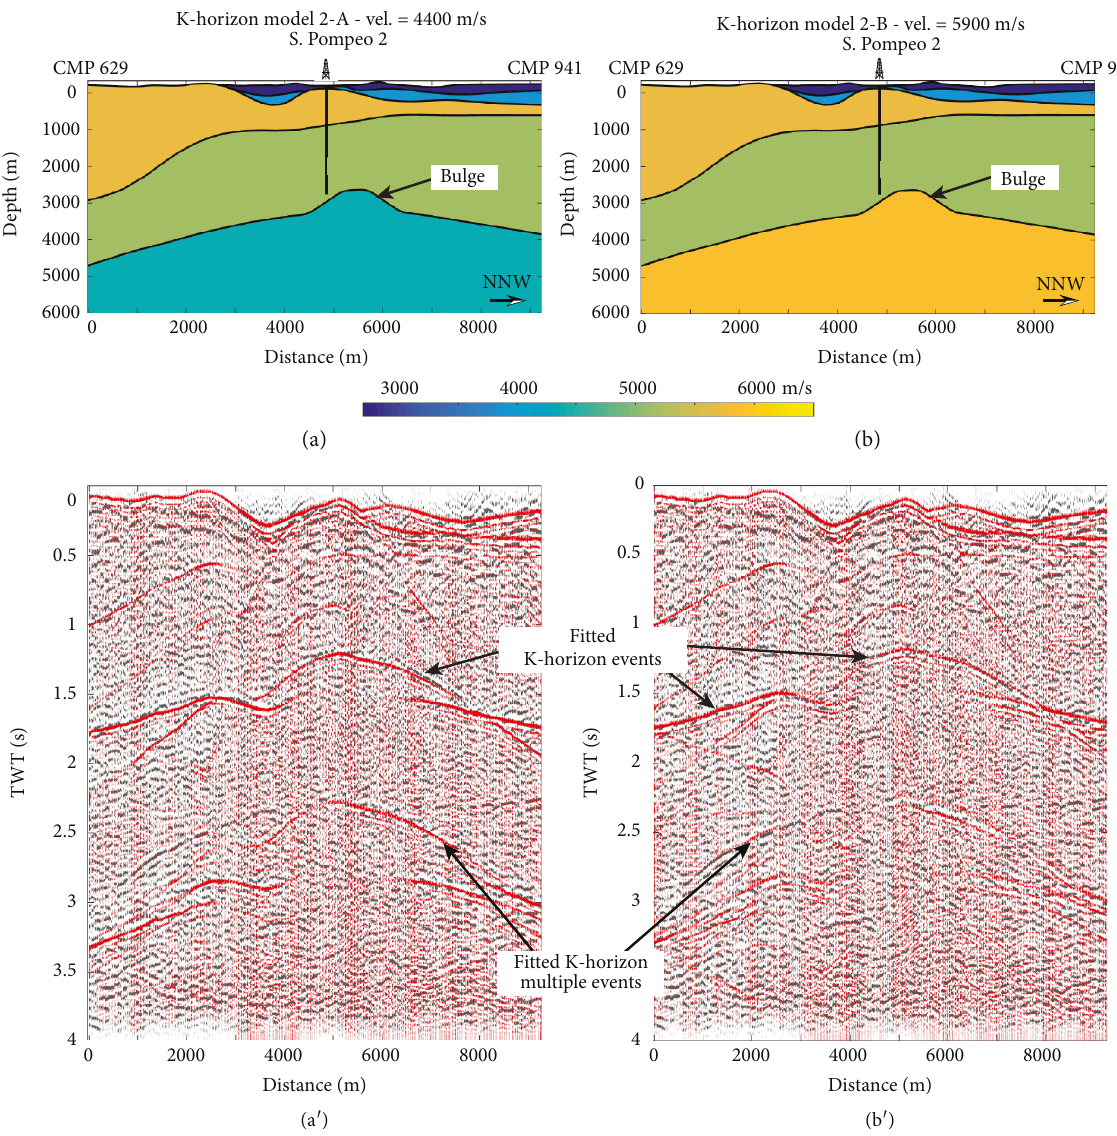
Figure 10: (a) Velocity model, named model 2-A, based on the 3D geological reconstruction obtained after the calibration with CROP-18A data and imposing a velocity value of 4400 m/s for the geological unit below the K-horizon. (b) Velocity model, named model 2-B, based on the 3D geological reconstruction after the calibration with CROP-18A data and imposing a velocity value of 5900m/s for the geological unit below the K-horizon. (a ′ ) Modelled stacked sections for model 2-A (a) with P velocity of the unit below the K-horizon of 4400 m/s. (b ′ ) Modelled stacked sections for model 2-B (b) with P velocity of the unit below the K-horizon of 5900m/s. The modelled seismic response, plotted in positive variable area in red, is superimposed onto the processed stacked data, plotted in